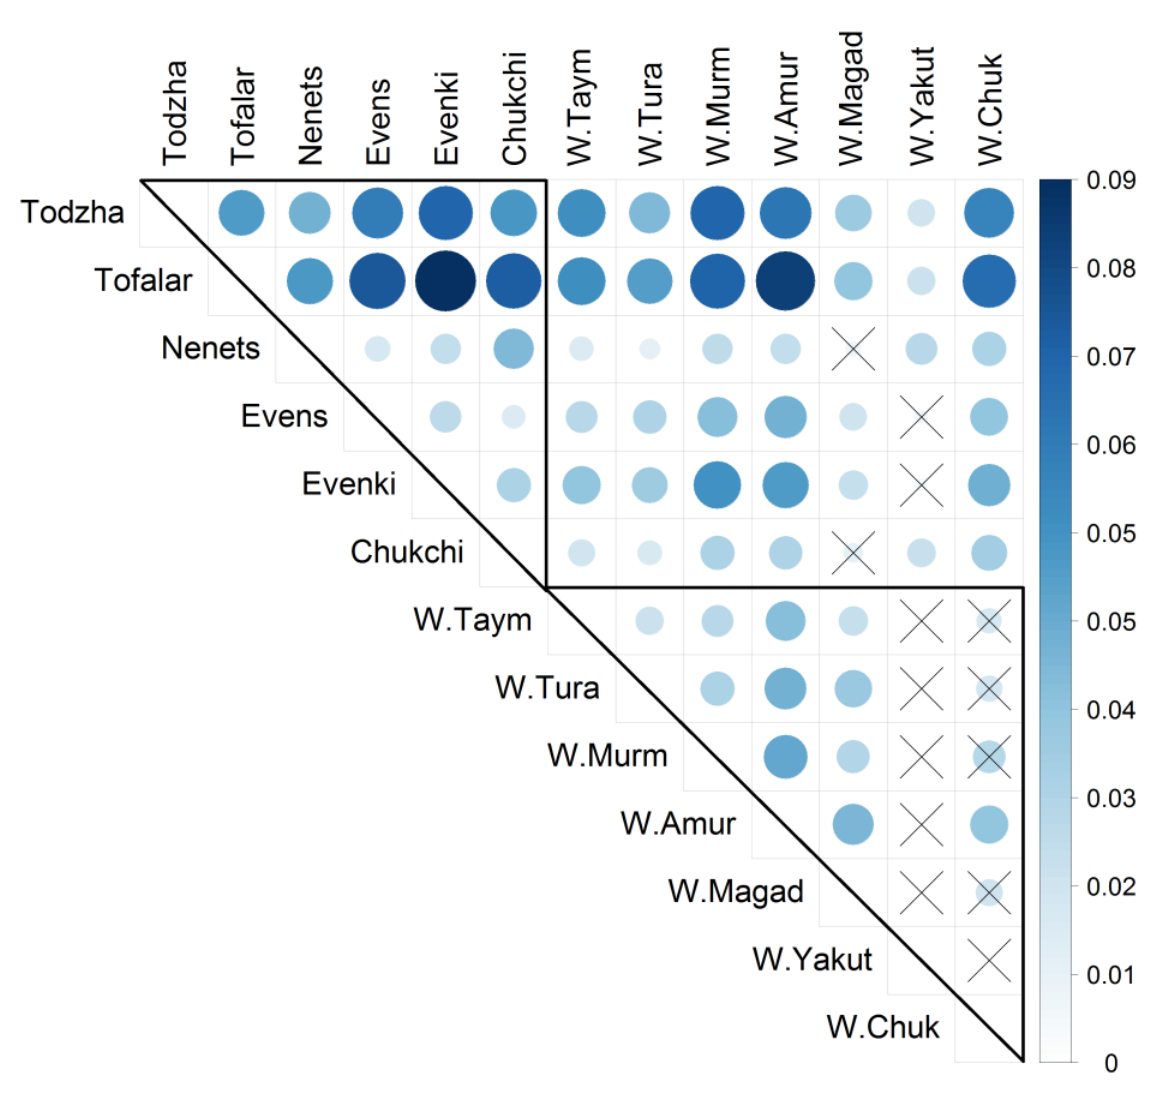
Figure 2. A visualization of pairwise Fst values. Colour intensity and size of circles are proportional to the pairwise Fst values between two population samples. Crosses indicate that no significant differences were found between two samples (p-value threshold = 0.05). The two black triangles separate domestic and wild reindeer